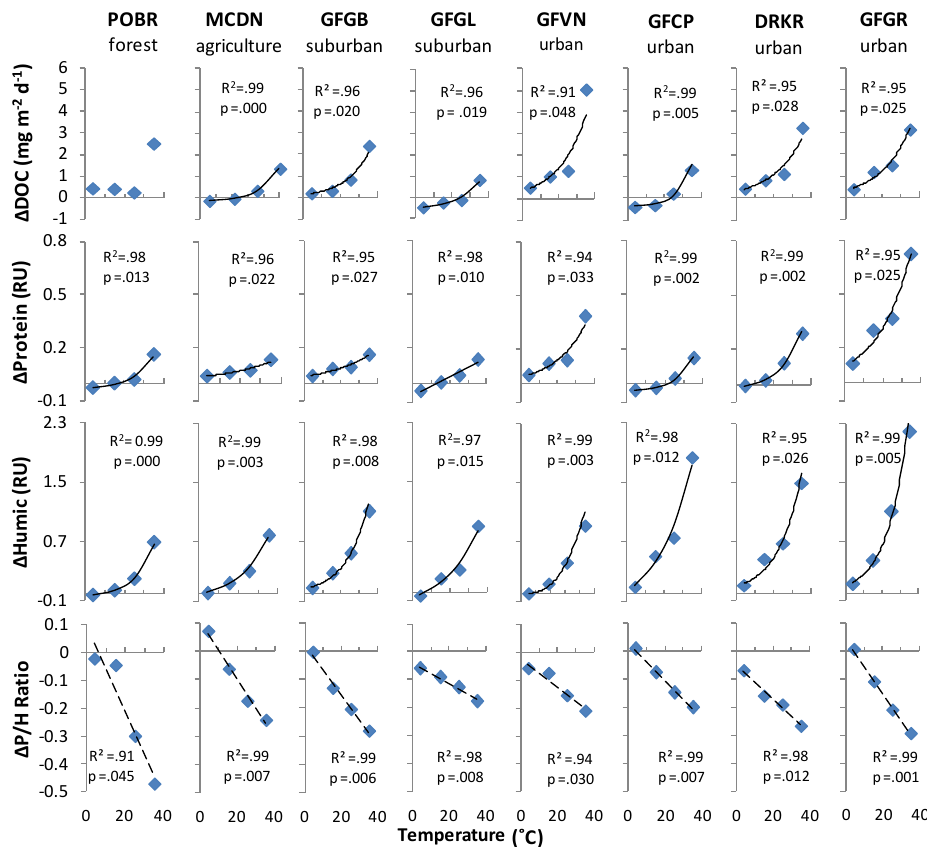
Fig. 4. Plots of DOC flux, or changes in protein-like fluorescence, humic-like fluorescence and their (P/H) ratio versus incubation temperature. Best fit regressions were exponential for DOC flux, or changes in protein-like fluorescence, humic-like fluorescence (in solid) and linear for P/H ratio (in dash). Regression without significant < 0 . 05 (DOC at POBR) was not added. Protein-like and humic-like fluorescence are in Raman Unit (RU). Table 3. Estimated sediment biogeochemical fluxes from stream sediments without (current ambient temperatures) and with increases in 5 ◦